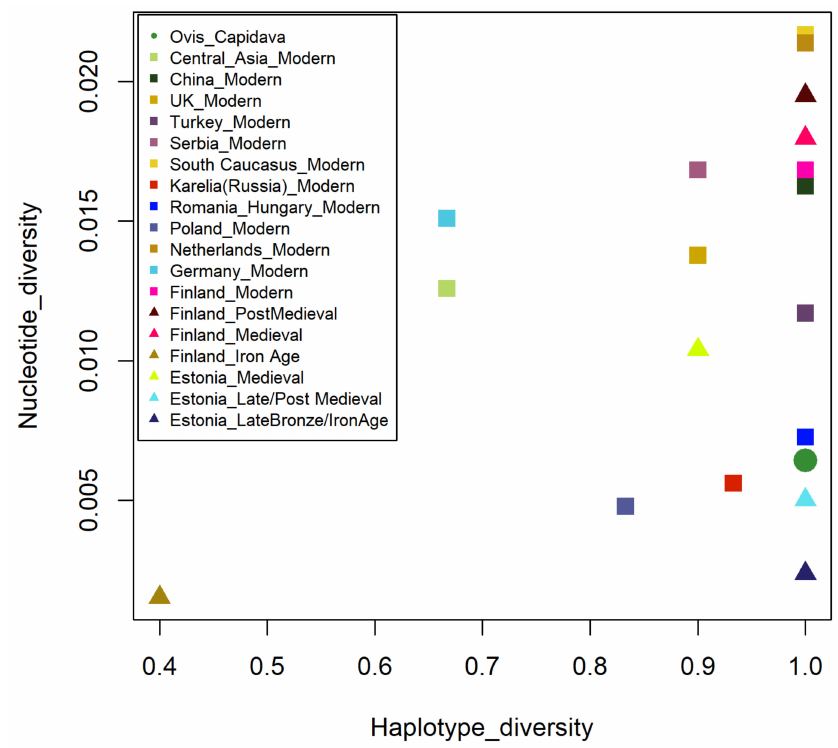
Figure 1. Scatterplot graph of haplotype and nucleotide diversities, comparing the Capidava cohort with modern and historical sequence sets.